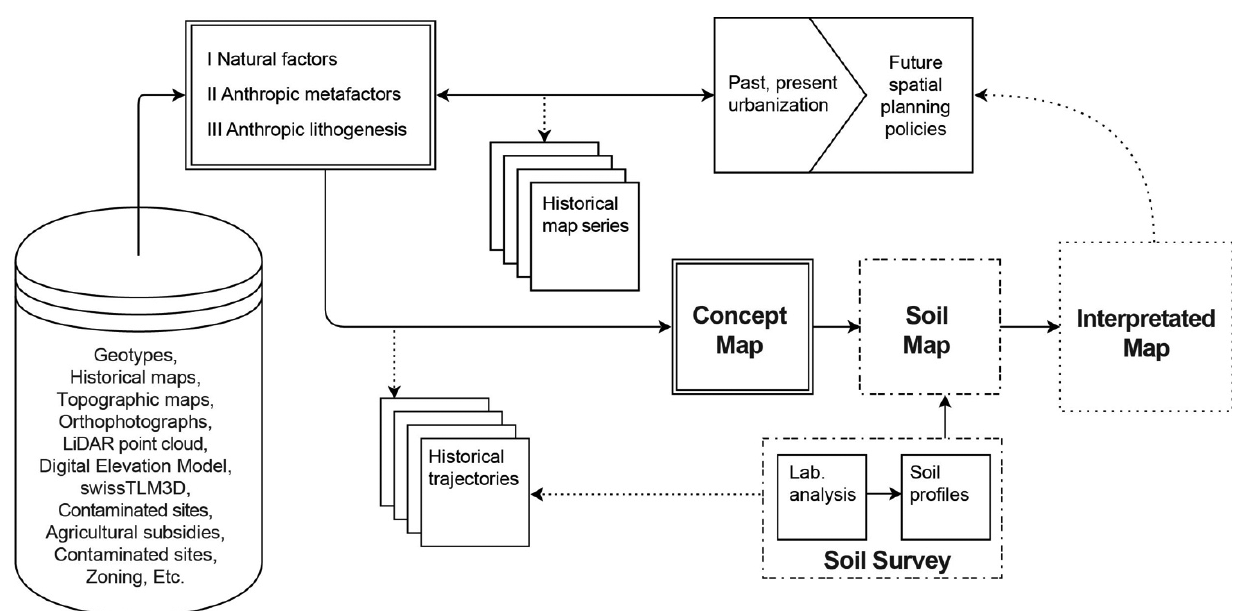
Figure 3. Workflow including source documents and outcome layers informing each other according to various mapping operations. Source: